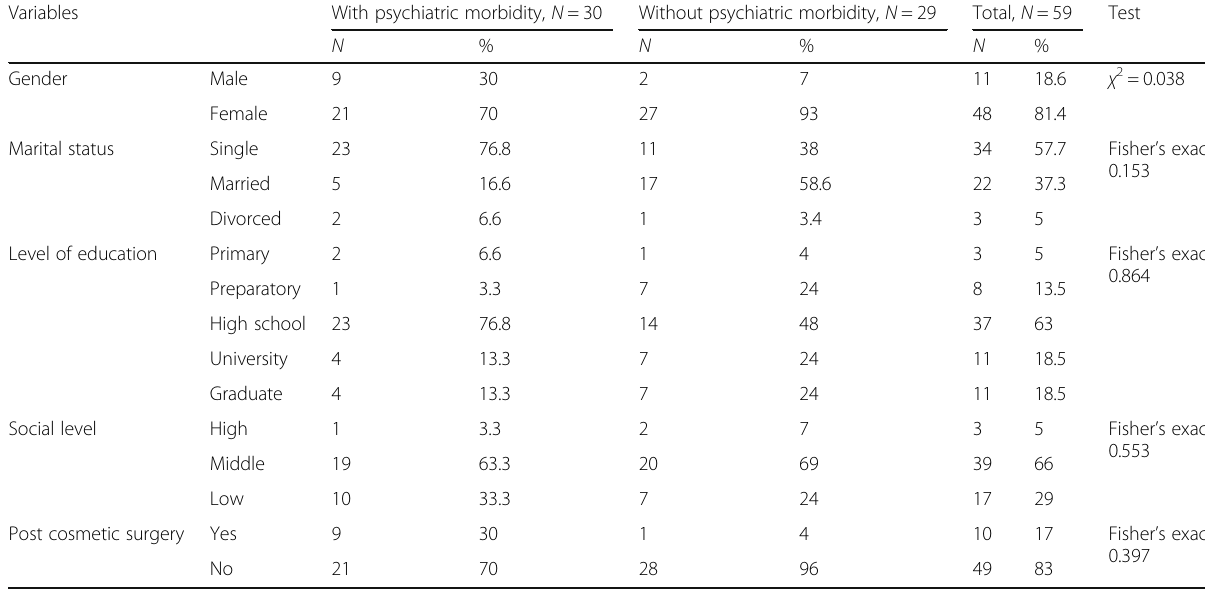
Table 1 Profile of patients seeking rhinoplasty with and without psychiatry